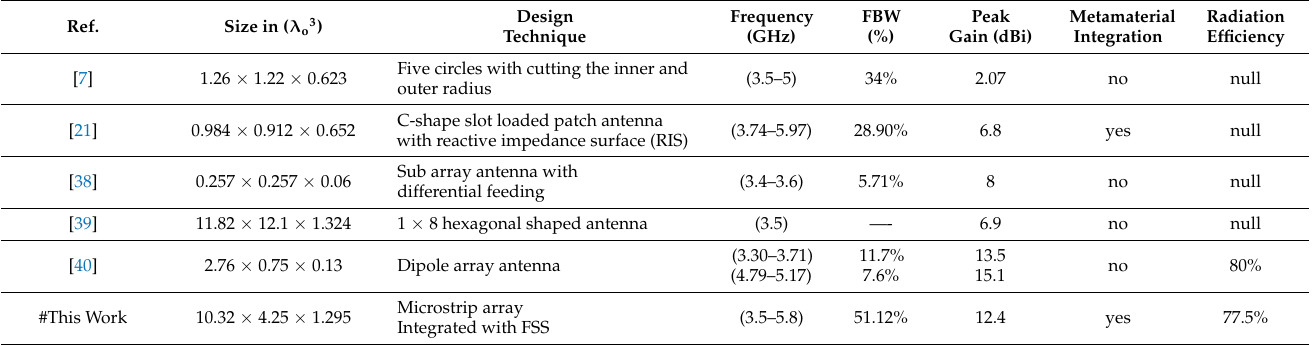
Figure 17. Current density distributions at 3.5 GHz for: ( a ) the FSS unit cell and ( b ) array antenna with the FSS reflector. Table 4. Optimum parameters for the slotted square ring (SSR) of the FSS